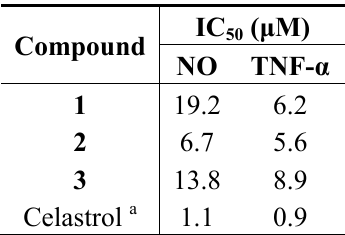
Table 2. IC values of the active compounds 1 – 3 against NO and TNF- α production in 50 RAW264.7